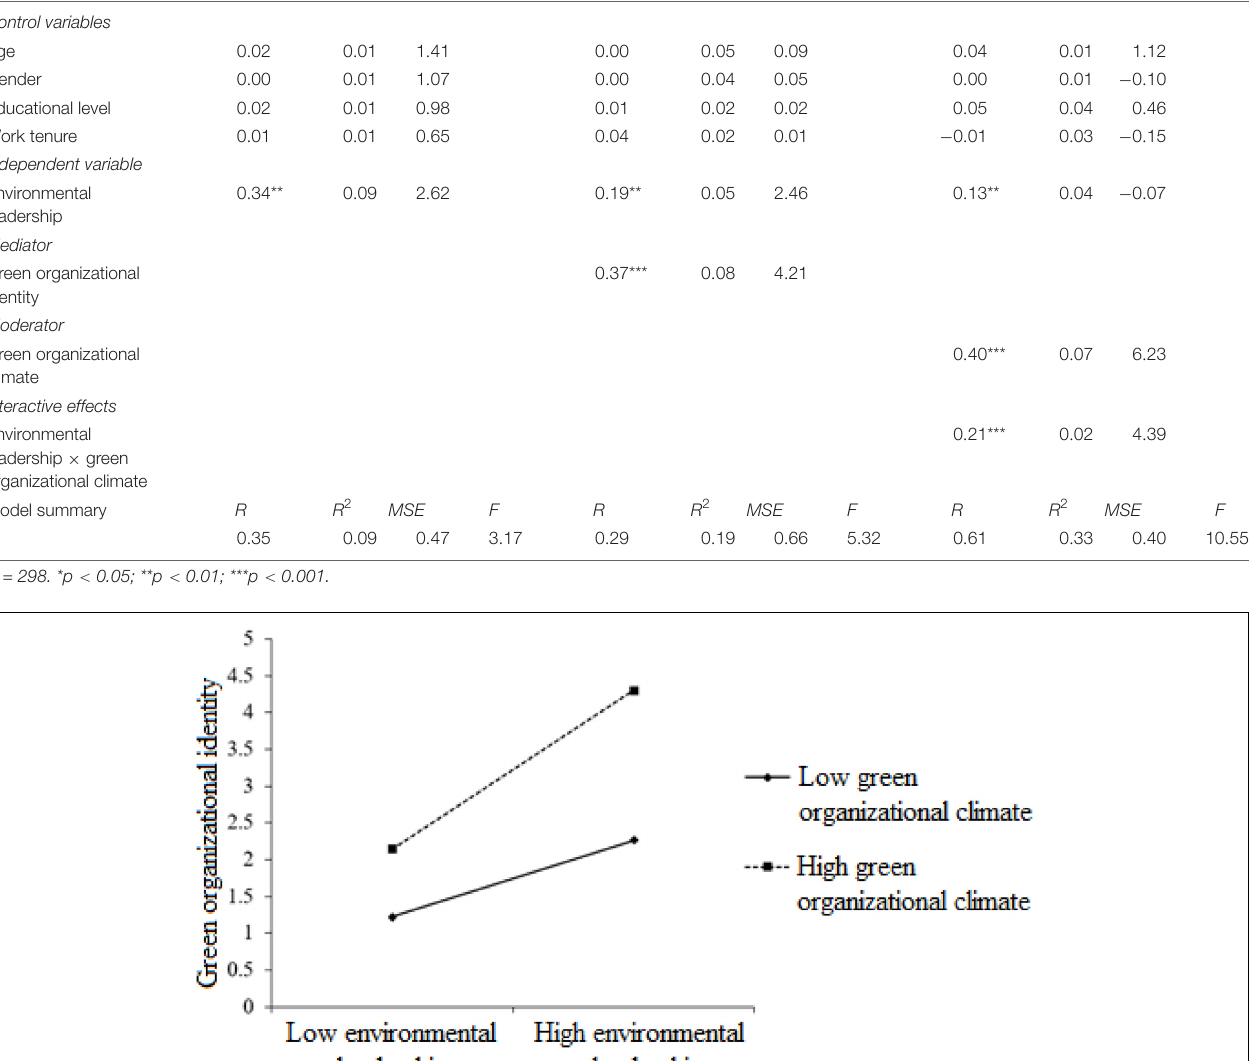
Outcome variable: Green innovation behaviors